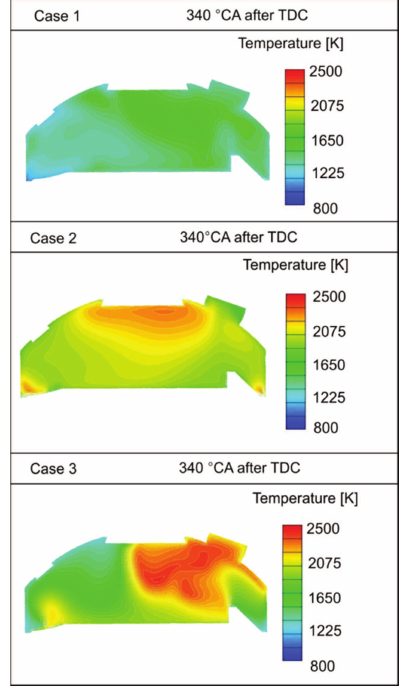
Fig. 6. Thermal stratification in the cylinder for 340 °CA after